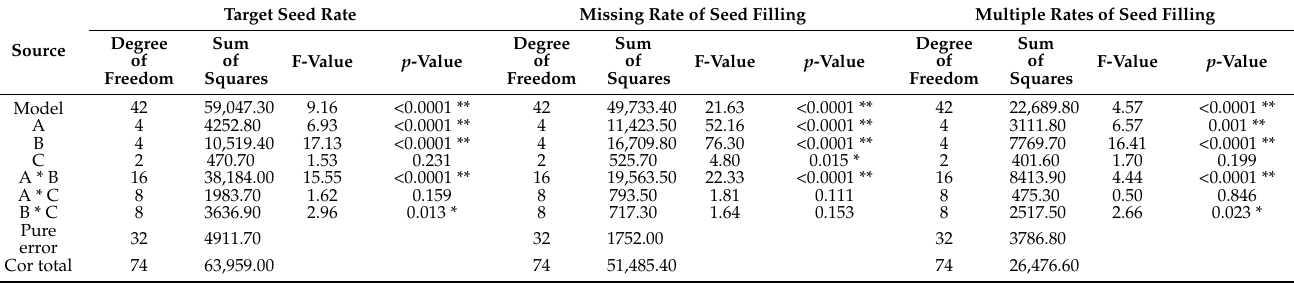
Table 6. Variance analysis of factors affecting seed-filling